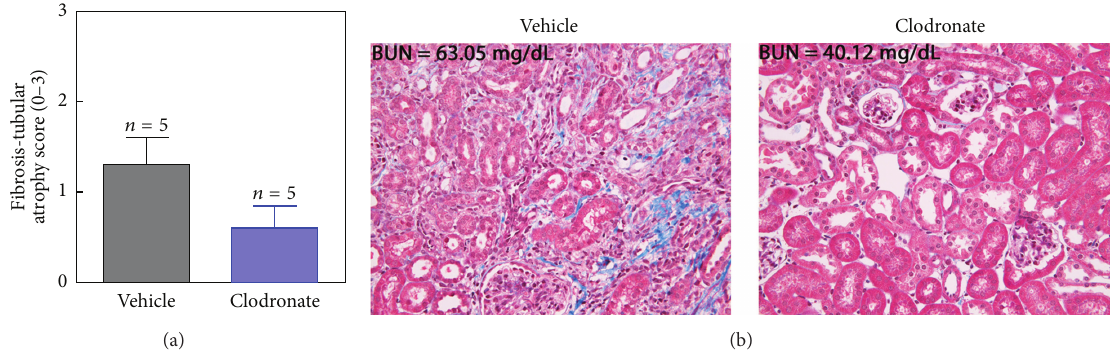
Figure 6: Interstitial fibrosis and tubular atrophy (IF/TA) scores at 14 days following release of UUO in vehicle- (black) and clodronate- (blue) treated mice (5 mice per treatment group, Y-error bars indicate SEM) (a). Representative Masson’s Trichrome staining is shown with the BUN for the representative animals